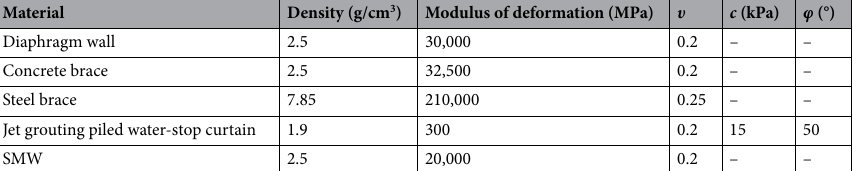
Table 4. Physical and mechanical parameters of the